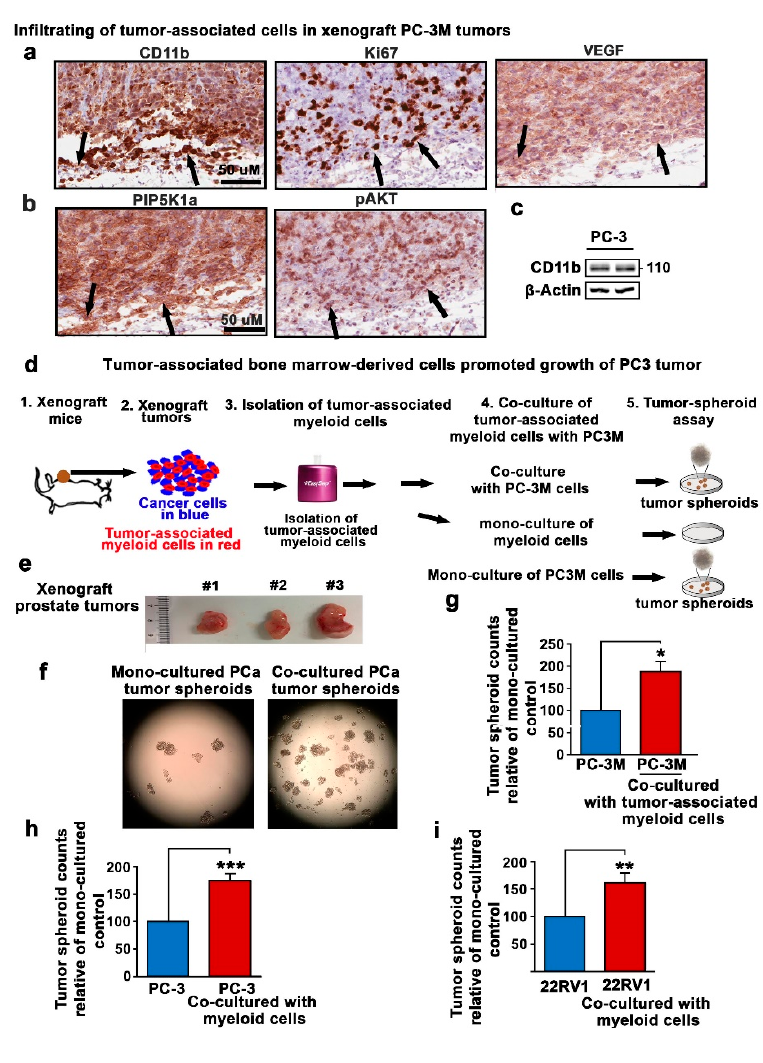
Figure 3. The effect of tumor-associated bone marrow-derived cells on the growth of tumor spheroids. ( a,b ) Immunohistochemical analysis of PC-3 xenograft tumors from mice using antibodies against CD11b, Ki67, pAKT, PIP5K1 α and VEGF. Representative microphotographs of the tumor tissues stained with the abovementioned antibodies are shown. ( c ) Immunoblot analysis of CD11b expression in PC-3 cells. Antibody against human CD11b was used. β -actin was used for loading controls. ( d ) The schematic illustrations show the procedures for the preparation of tumor-infiltrated myeloid cells from xenograft PC-3 tumors from mice. Tumors were dissected and made into single-cell suspensions. The Lin+ cells were isolated by using an EasySep kit for the isolation of mouse hematopoietic cells from bone marrow. The Lin+ cells and PC-3M cells were subjected to mono-culture or co-culture for tumor-spheroid formation assays. The spheroids were counted and quantified after 14 days. ( e ) Representative image of the tumors that were used for the isolation of Lin+ cells is shown. ( f ) Representative images of the tumor spheroids derived from mono-cultured PC-3M or PC-3M and Lin+ cells are shown. ( g ) A bar chart indicating the relative counts of tumor spheroids derived from mono-cultured PC-3M or PC-3M and Lin+ cells co-cultured together is shown ( p = 0.009). ( h ) A bar chart indicating the relative counts of tumor spheroids derived from mono-cultured PC-3 cells or PC-3 and Lin+ cells co-cultured together is shown ( p < 0.001 is indicated as “***”). ( i ) A bar chart indicating the relative counts of tumor spheroids derived from mono-cultured 22Rv1 cells or 22Rv1 cells and Lin+ cells co-cultured together is shown ( p = 0.01). p < 0.05 is indicated as “*”, p < 0.01 is indicated as “**”.